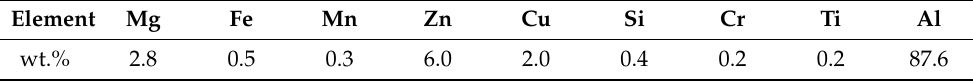
Table 1. Chemical compositions (wt.%) of 7075 aviation actuator aluminum alloy. Element Mg Fe Mn